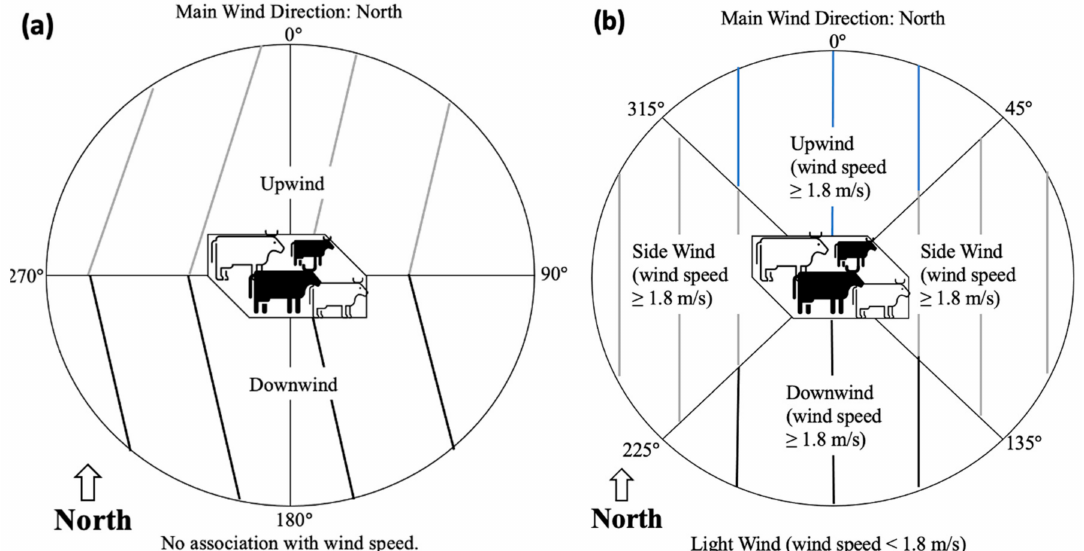
Figure 2. Two different categorizations ( a , b ) for indicating position of the air sampler relative to feedlot location and wind direction, with an example when wind comes from the north: ( a ) With prevailing wind direction set at 0 ◦ , downwind from a feedlot is a 180 ◦ partition of 270 ◦ to 90 ◦ , and upwind from a feedlot is a 180 ◦ partition of 270 ◦ to 90 ◦ . ( b ) With wind direction set at 0 ◦ , downwind from a feedlot is a 90 ◦ partition or 135 ◦ to 225 ◦ when windspeed is ≥ 1.8 m/s (4 mph); other category includes 90 ◦ partitions for upwind (315 ◦ to 45 ◦ ) and both lateral sidewinds (45 ◦ to 135 ◦ and 225 ◦ to 315 ◦ ) when wind speed is ≥ 1.8 m/s (4 mph); and light wind is when wind speed is <1.8 m/s (4